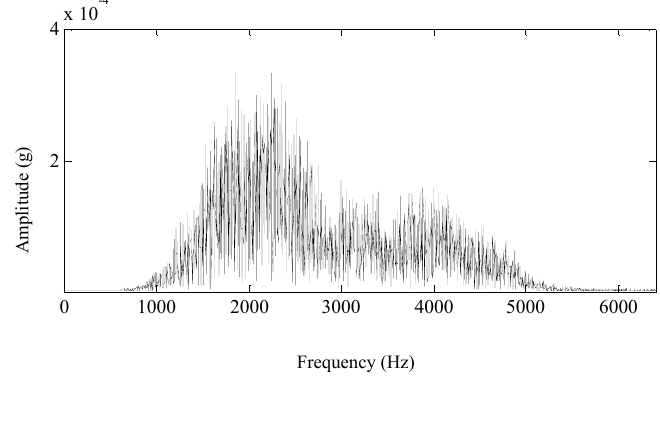
Figure 19. The Fourier spectrum of the denoising result using the proposed